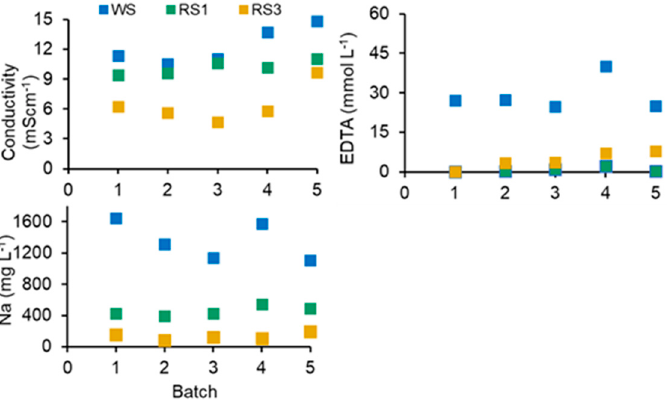
Figure 3. The properties of the recycled washing, first, and third rinse solutions (WS, RS1, and RS3, respectively) over the five successive washing batches.